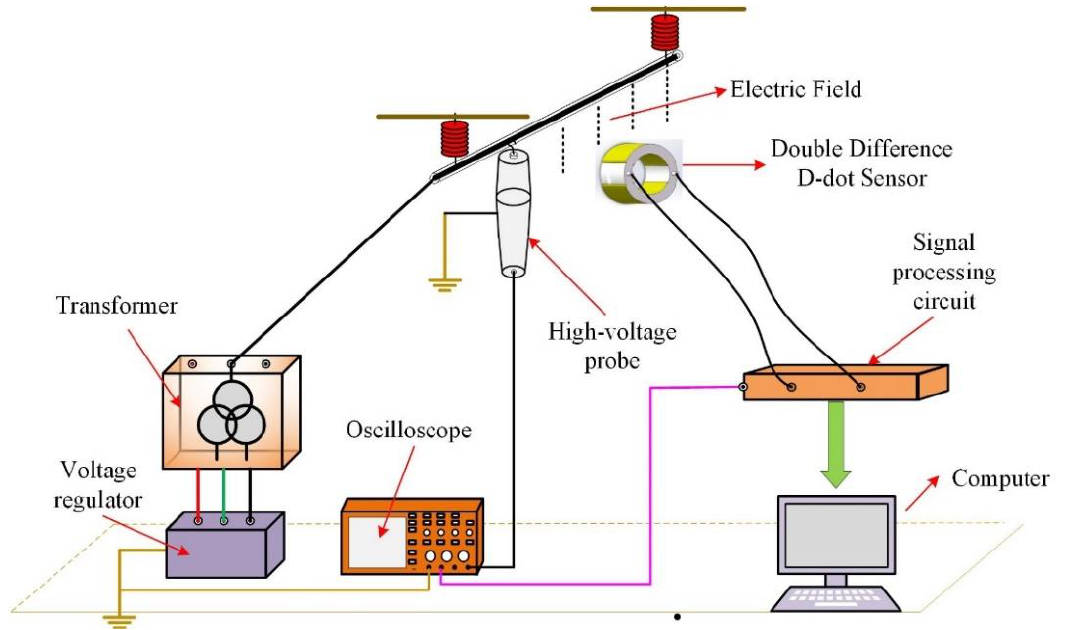
Figure 10. The structure diagram of the test platform.